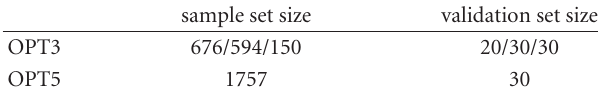
Table 3: Sample and validation set sizes for the two metamodels. sample set size validation set